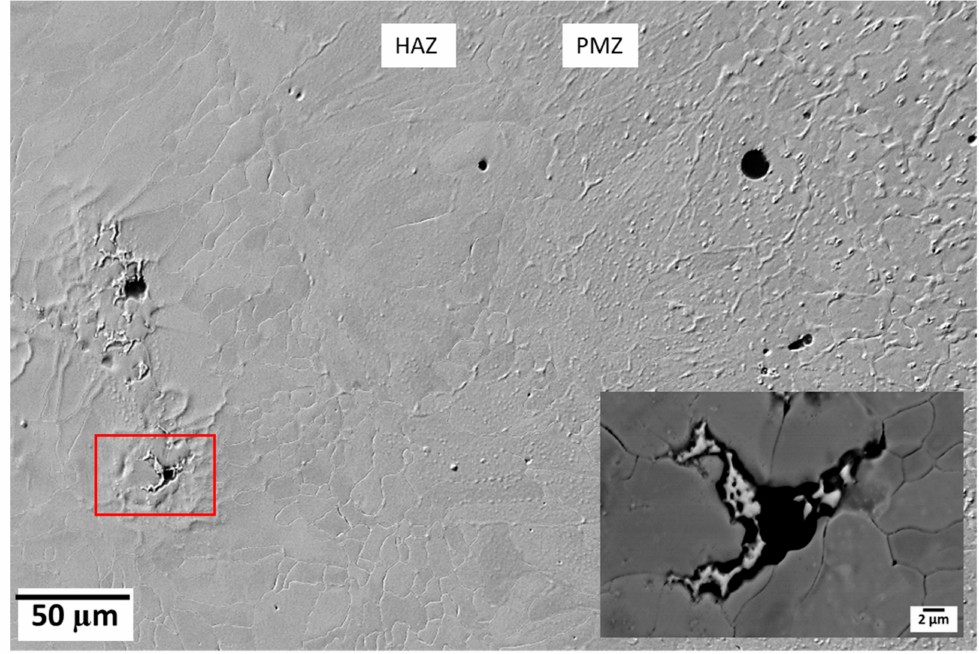
Figure 10. HAZ liquation cracking in SHT condition; inset showing the marked